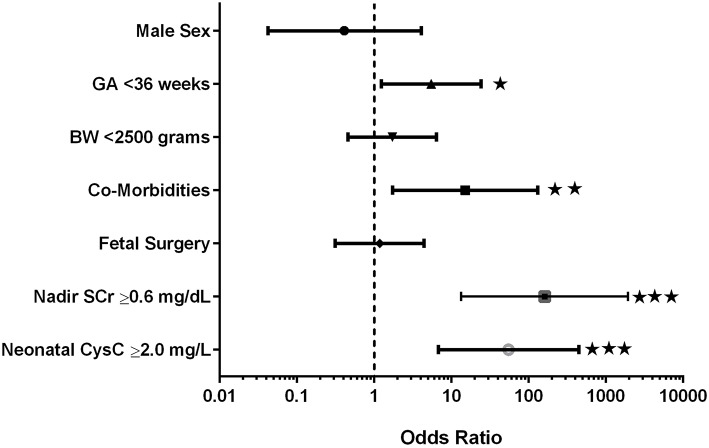
Odds ratios for prediction of early progression to advanced kidney disease. ⋆p < 0.05; ⋆⋆p < 0.01; ⋆⋆⋆p < 0.001.